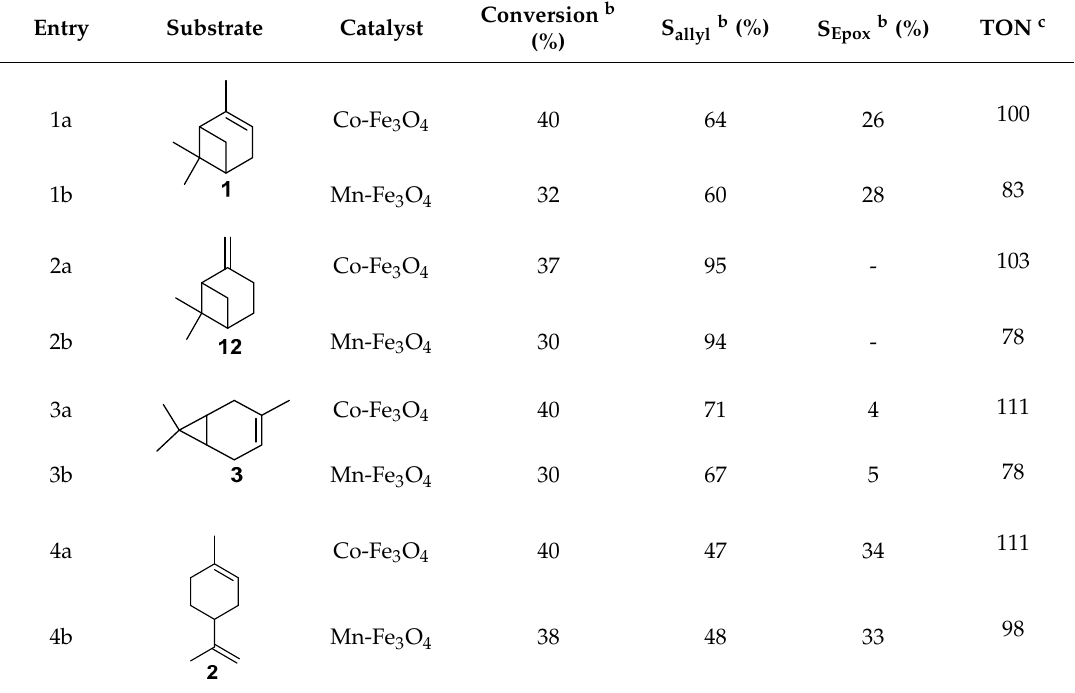
Table 21. Aerobic oxidation of terpenic olefins with Co- and Mn-substituted ferrites a (adapted from reference [74]). Entry Substrate Catalyst Conversion b (%)